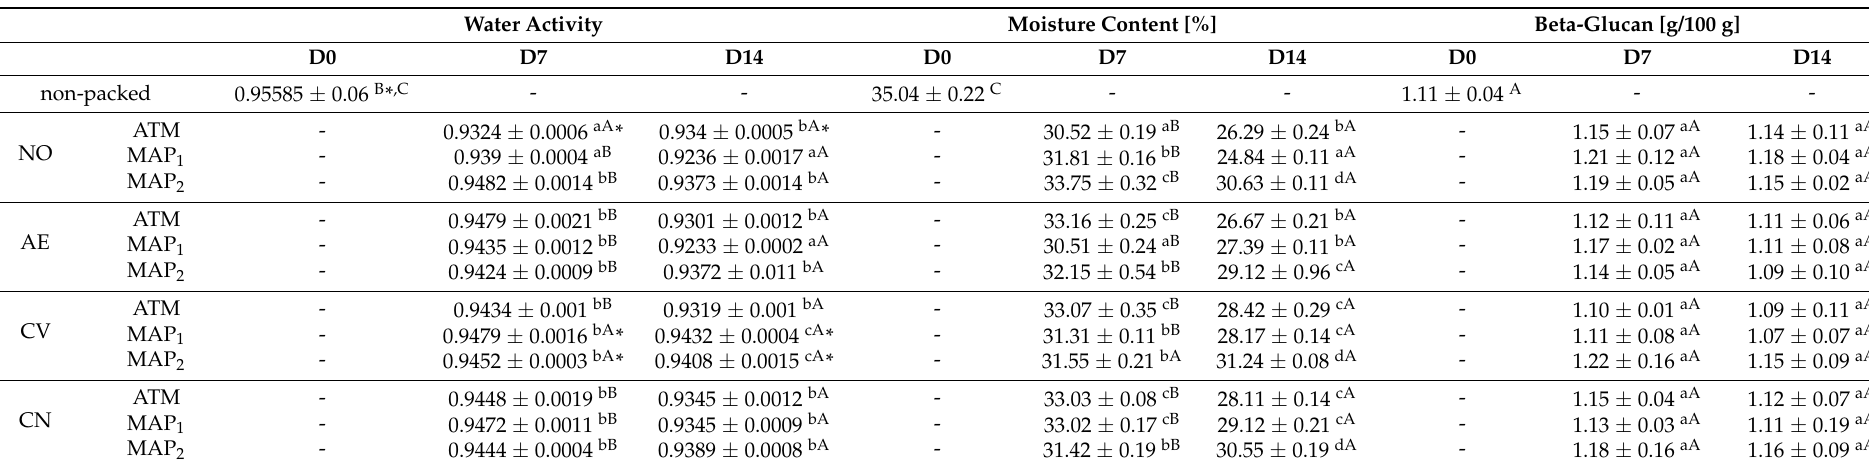
Table 2. The water activity, moisture content [%], and content of beta-glucan [g/100 g] of GF cake (mean ± SD; n = 3).